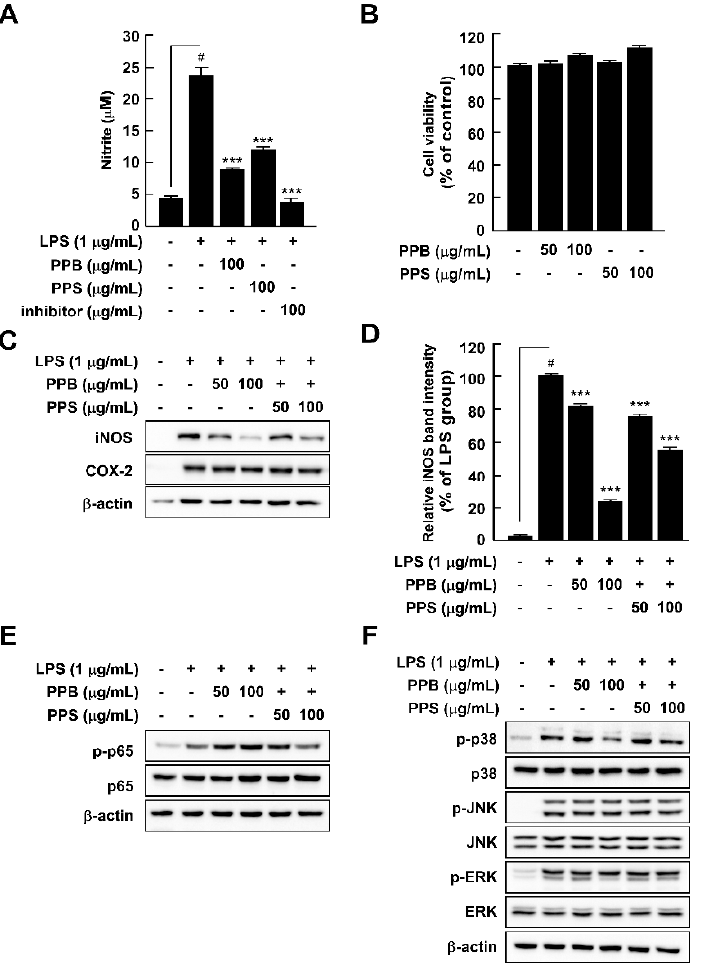
Figure 3. Effects of pink pepper extract (PPE) on lipopolysaccharides (LPS)-mediated nitrite production, cell viability, iNOS and COX-2 expression, and p65 and MAPK phosphorylation in RAW264.7 cells. ( A ) PPE suppressed LPS-induced nitrite production in RAW264.7 cells. ( B ) PPE did not affect cell viability for 24 h. ( C ) PPE inhibited LPS-induced iNOS expression in RAW264.7 cells, but did not alter COX-2 protein expression. ( D ) Quantification of iNOS expression. ( E ) PPE suppressed LPS-induced phosphorylation of p65 in RAW264.7 cells. ( E ) PPE did not affect LPS-induced phosphorylation of p65 in RAW264.7 cells ( F ) PPE inhibited LPS-induced phosphorylation of p38, but not JNK and ERK. Data are presented as the mean ± standard deviation of three independent experiments. # p < 0.05 between control and LPS-exposed cells (no PPE); *** p <